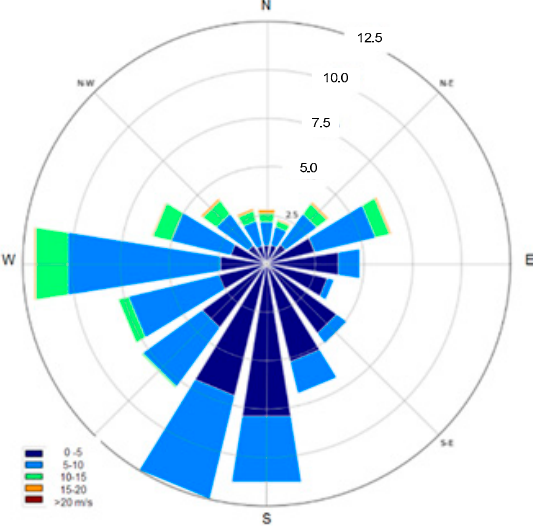
Figure 5. The wind rose for Ustka Port. (wind 1 h averaged, data from 2000–2020).